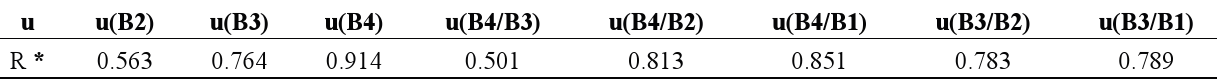
Table 2. The correlation coefficients between SSC measurements and the associated u = b b /(a + b b ) retrieved from R rs measurements using QAA, given various Landsat5 TM bands and band